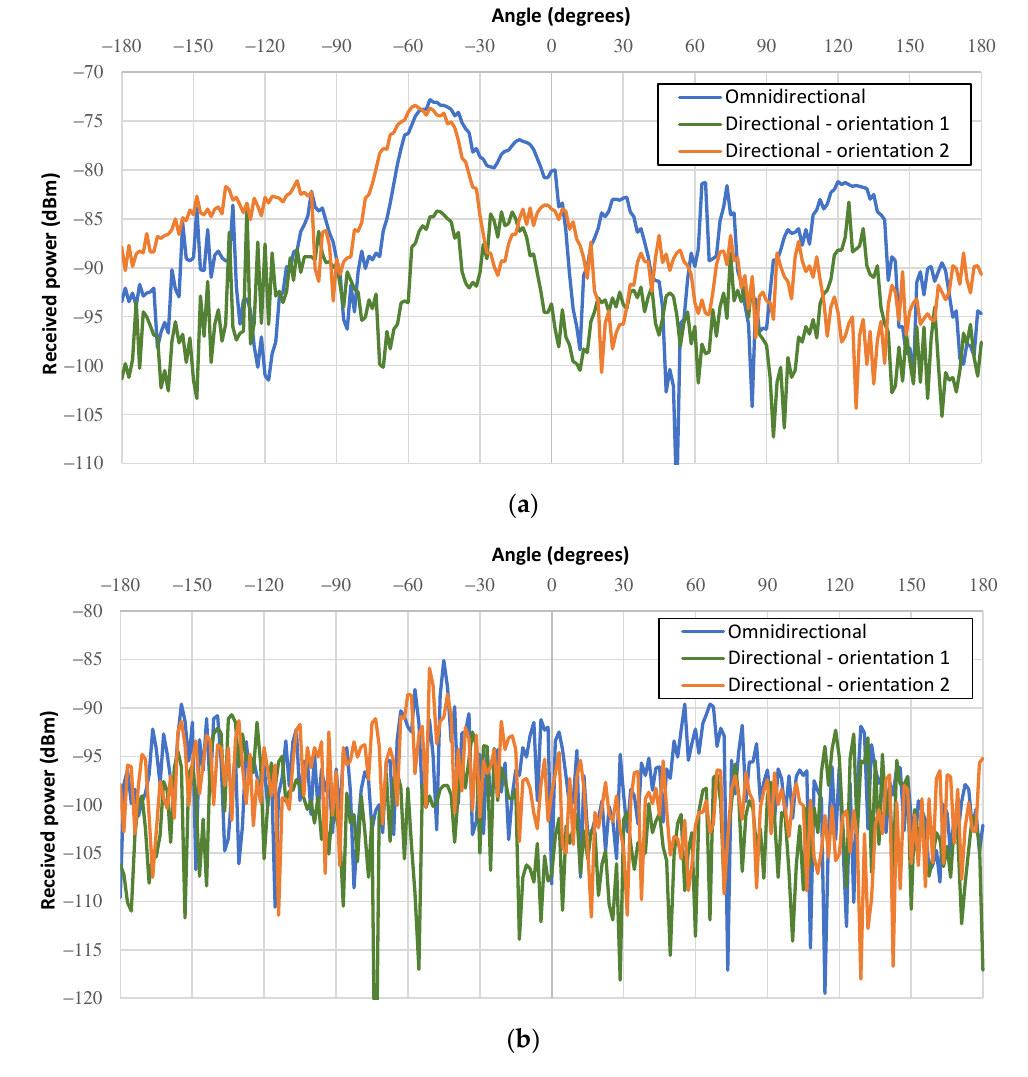
Figure 6. Measurements results with a signal generator: ( a ) received power; ( b ) received signal after deconvolution.